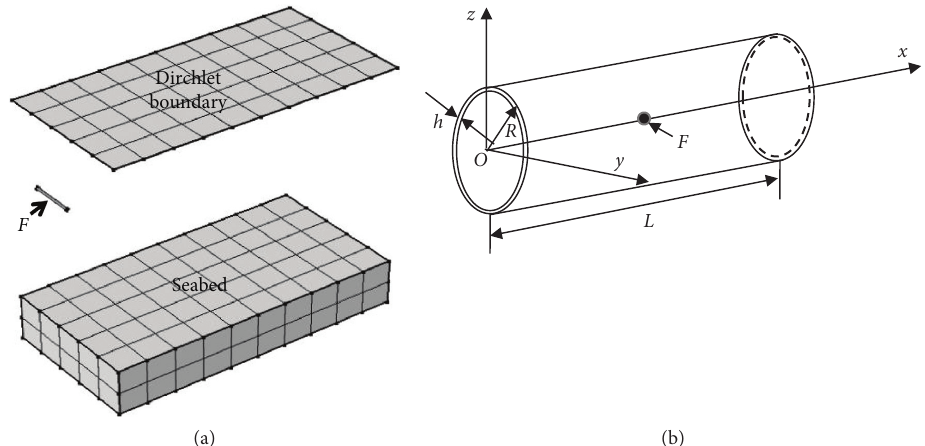
Figure 1: (a) The acoustic radiation model of structure in a Pekeris waveguide. (b) The sketch map of the cylindrical shell with finite